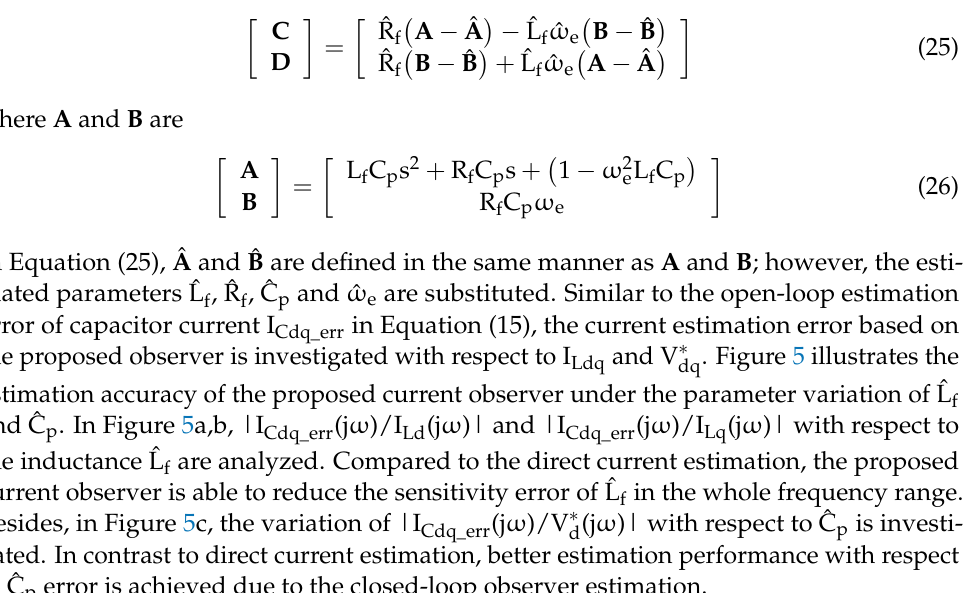
( b ) Figure 9. Machine three-phase currents and the corresponding spectrum for the drive ( a ) without and ( b ) with LC filter (40 krpm and fan load). 5.2. LC Filter Effect on FOC Drive This part demonstrates the influence of the LC filter on the FOC machine drive. Figure 10 compares three different A-phase currents—the inverter output current, I LA , capacitor current I CA and machine actual current I A in Figure 1, respectively—at (a) a low speed of 1 krpm and (b) high speed of 40 krpm. As seen in Figure 10a, the inverter current I LA and machine current I A were nearly the same, while the capacitor current I CA contained some PWM harmonics. Besides, current waveform distortion was observed on both I LA and I A . In general, the PWM inverter contained the deadtime effect, affecting the current regulation, especially at low speed. In this paper, the dead-time compensation was applied based on the direct voltage compensation dependent on the phase current polarity [25]. In contrast, at high speed, as shown in Figure 10b, a visible magnitude and phase difference between I LA and I A were observed due to the high magnitude of I CA . Based on this experiment, it is concluded that, at high speed, the actual machine current I A must be obtained to stabilize the FOC drive.